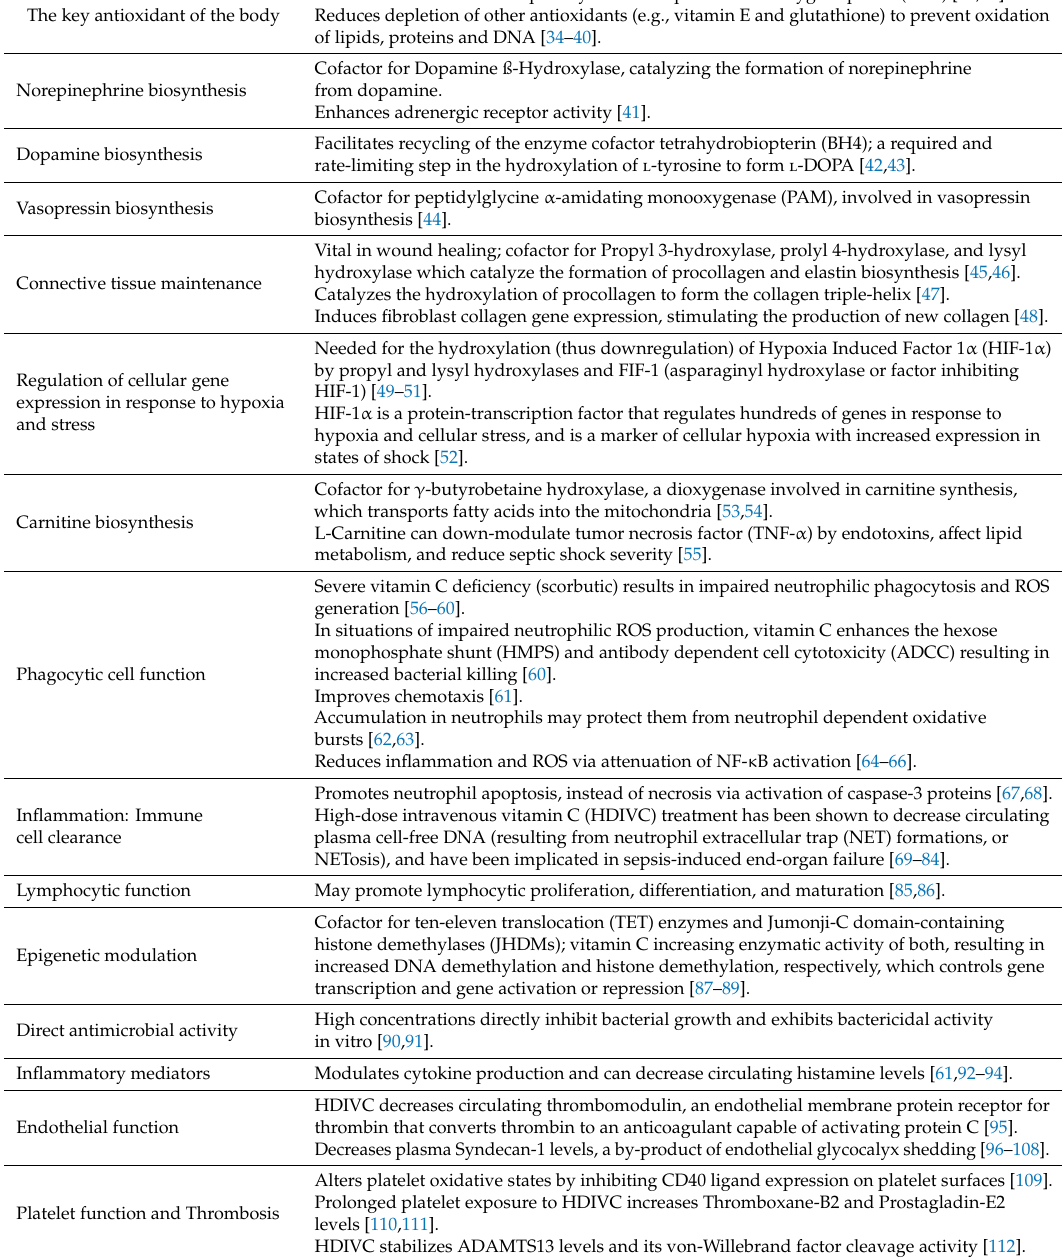
Table 1. Pleiotropic physiologic functions of vitamin